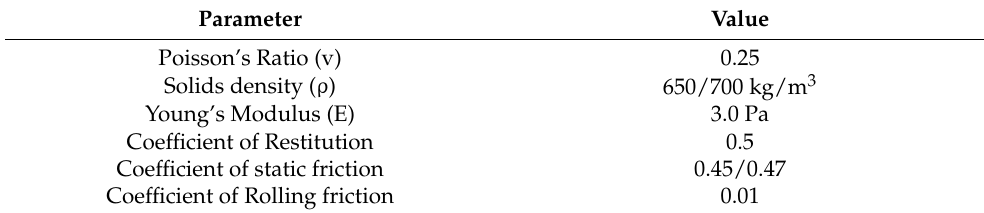
Table 4. Properties used in EDEM for particle-particle connection evaluation.